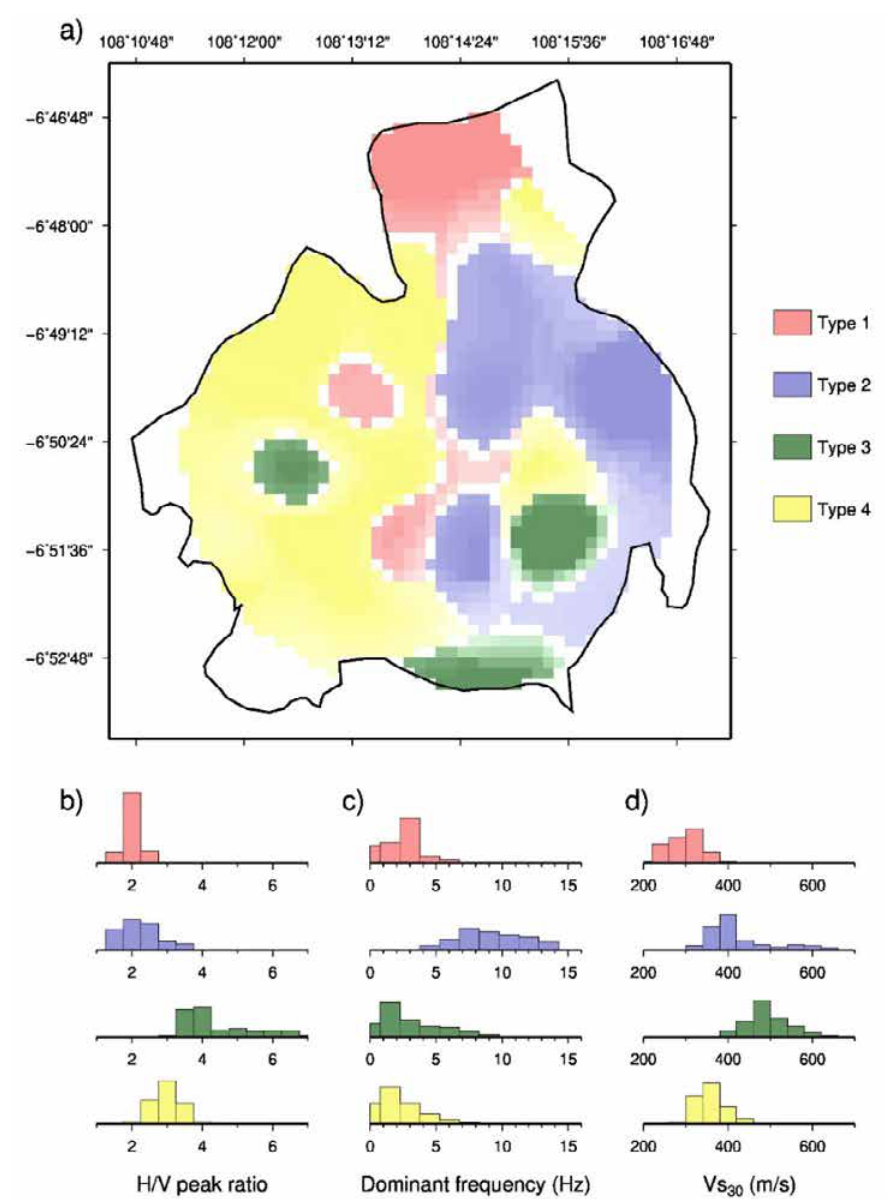
Fig. 6: (a) Geographic distribution of four types of near-surface rocks and vulnerability based on neural network clustering of petrophysical properties in Majalengka. Histograms of (a) H/V peak ratio, (b) dominant frequency, and (c) Vs 30 for Types